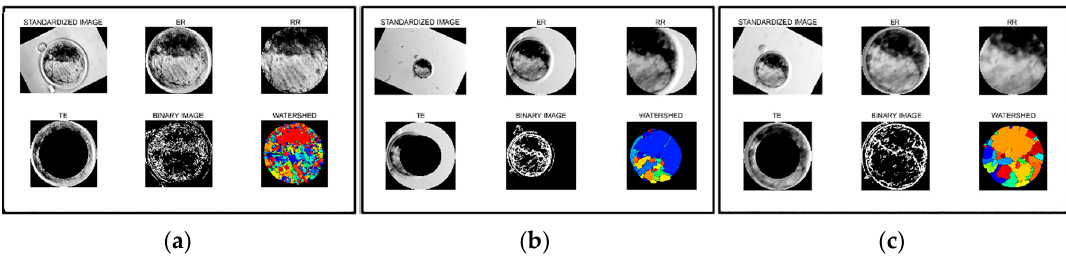
Figure 3. Illustrative comparison among the segmentation of the images from the same embryo but captured by: ( a ) An inverted microscope (control group; Dataset 1), ( b ) a smartphone and without the use of the scaling algorithm software (experimental group I; Dataset 1), and ( c ) a smartphone and after application of the scaling algorithm (experimental group II; Dataset 1). Full (a,c) and partial segmentation (b) were observed depending on the source of the image (a,b) and the use of scaling algorithm (b,c).